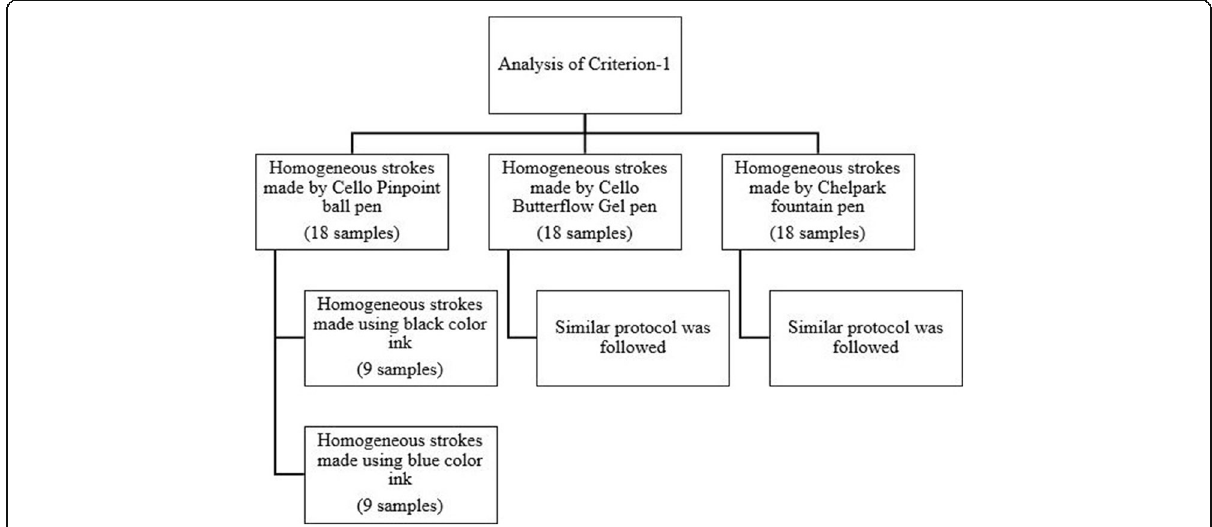
Fig. 2 Graphical representation illustrating the protocol of producing samples for criterion 1